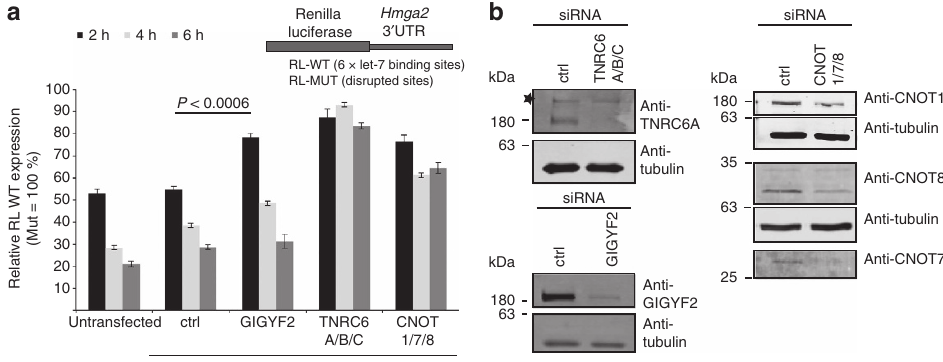
Figure 9 | Validation of novel miRISC-regulating factor. ( a ) Dual luciferase assay following knockdown experiments with the indicated siRNA pools performed in stable inducible cell lines expressing the depicted renilla luciferase reporters. The bars show the expression levels of the RL-WT reporter (with miRNA-binding sites) normalized to a co-expressed control firefly luciferase reporter at the indicated time points after induction. Expression levels are indicated as percentages of values for the matching non-repressed MUTreporter (with no miRNA-binding sites), which are set to 100% at each time point. At 2h post induction, miRNA-mediated repression is significantly alleviated on knockdown of GIGYF2. P value was calculated using a two-tailed student’s paired t -test ( n ¼ 6, error bars are s.e.m.). ( b ) Western blots showing knockdown efficiency of the siRNAs used in a . Unspecific bands are labelled with a